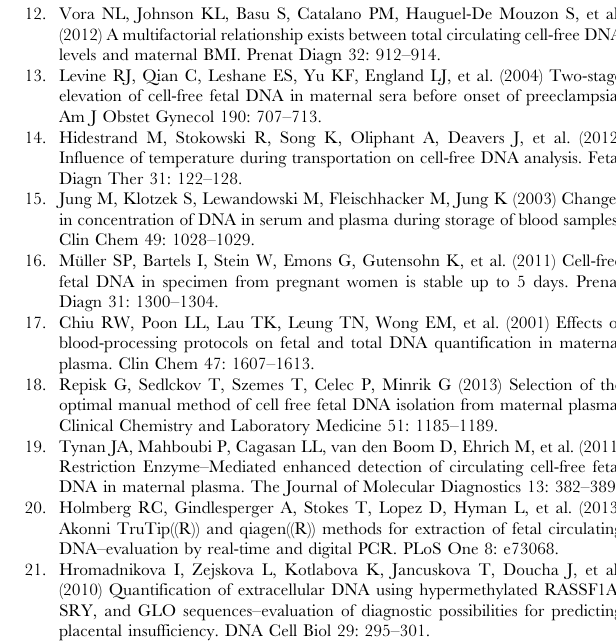
Figure S2 Visual representation of ddPCR results for serial dilutions. The Y axis represents the fluorescent intensity and the X axis shows the number of events (positive events are above the threshold line). Each plot represents the data from one channel (Ch1: FAM ( SRY ), Ch2: VIC ( RPP30 )). B01 Non-template control (water), B02–B08 – Seven four-time dilutions within a range of 9438–2.3 GE/mL. Figure S3 Evaluation of placental cfDNA for individual samples over a range of gestational ages. Specific values: *- Preeclampsia with HELLP Syndrome at 29th week of gestation, { - IUGR in twins, { -Neural tube defect. Figure S4 Correlation plots. A. Logged concentrations of total ( RPP30 ) and placental ( SRY , RASSF1A ) cfDNA obtained using qPCR and ddPCR. B. Logged concentrations of placental cell- free DNA measured with SRY and RASSF1A using different PCR techniques. Table S1 Case summary (patient samples with corre- sponding processing time, gestational age, total and fractional placental DNA concentrations measured with qPCR and ddPCR).